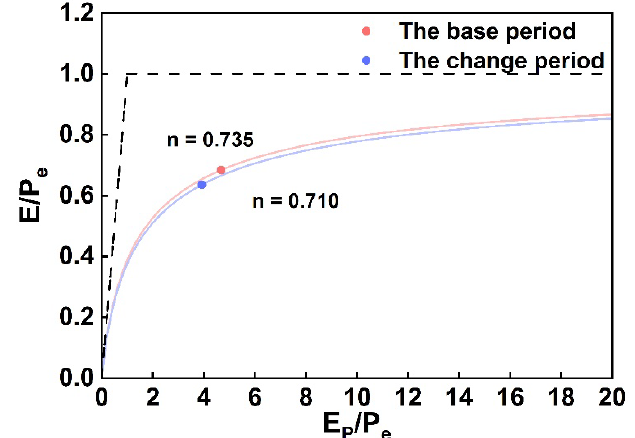
Figure 4. The data points of the two periods in the Budyko space. The red one was the Budyko curve with a parameter n of 0.735. The blue one was the Budyko curve with a parameter n of 0.710. The horizontal dotted line represented the water limitation, and the sloping dotted line represented the energy limitation.